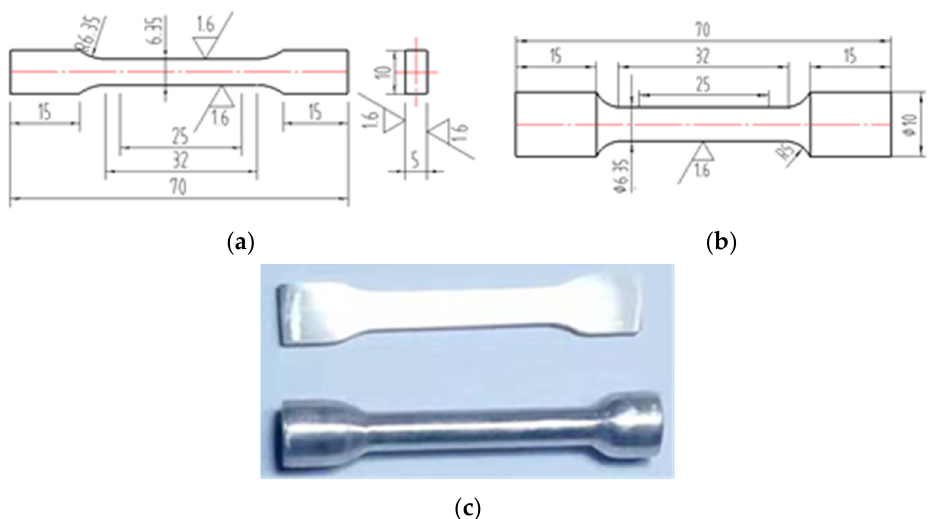
Figure 1. Dimensioned schematics of the tensile samples used for ( a ) as-cast Mg alloys, ( b ) as-extruded and aged Mg alloys (unit: mm), and ( c ) actual tensile samples.